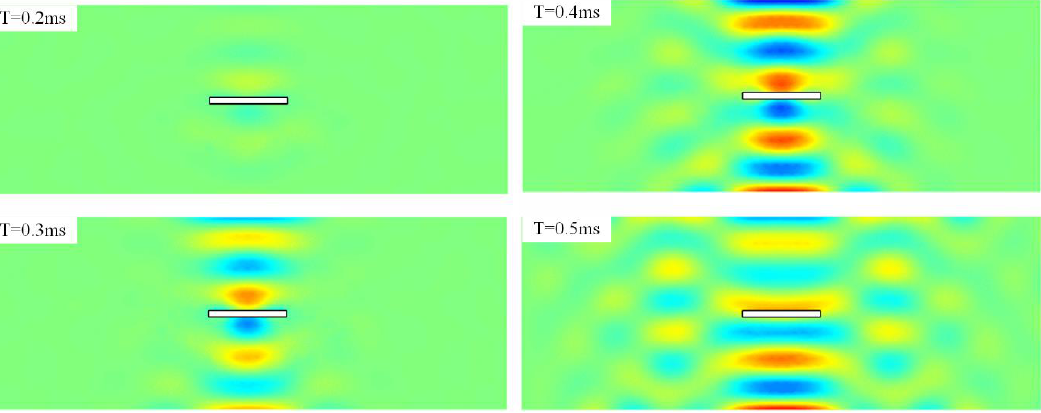
Figure 6. The subtracted full-field displacement response within 0.2 to 0.5 ms by the baseline subtraction method.